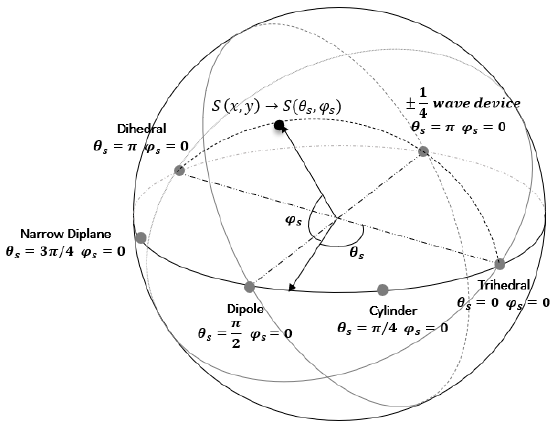
Figure 4. Illustration of mapping of a point (x , y) on the unit disk to the unit sphere as well as the positions taken by the symmetric scattering mechanisms.